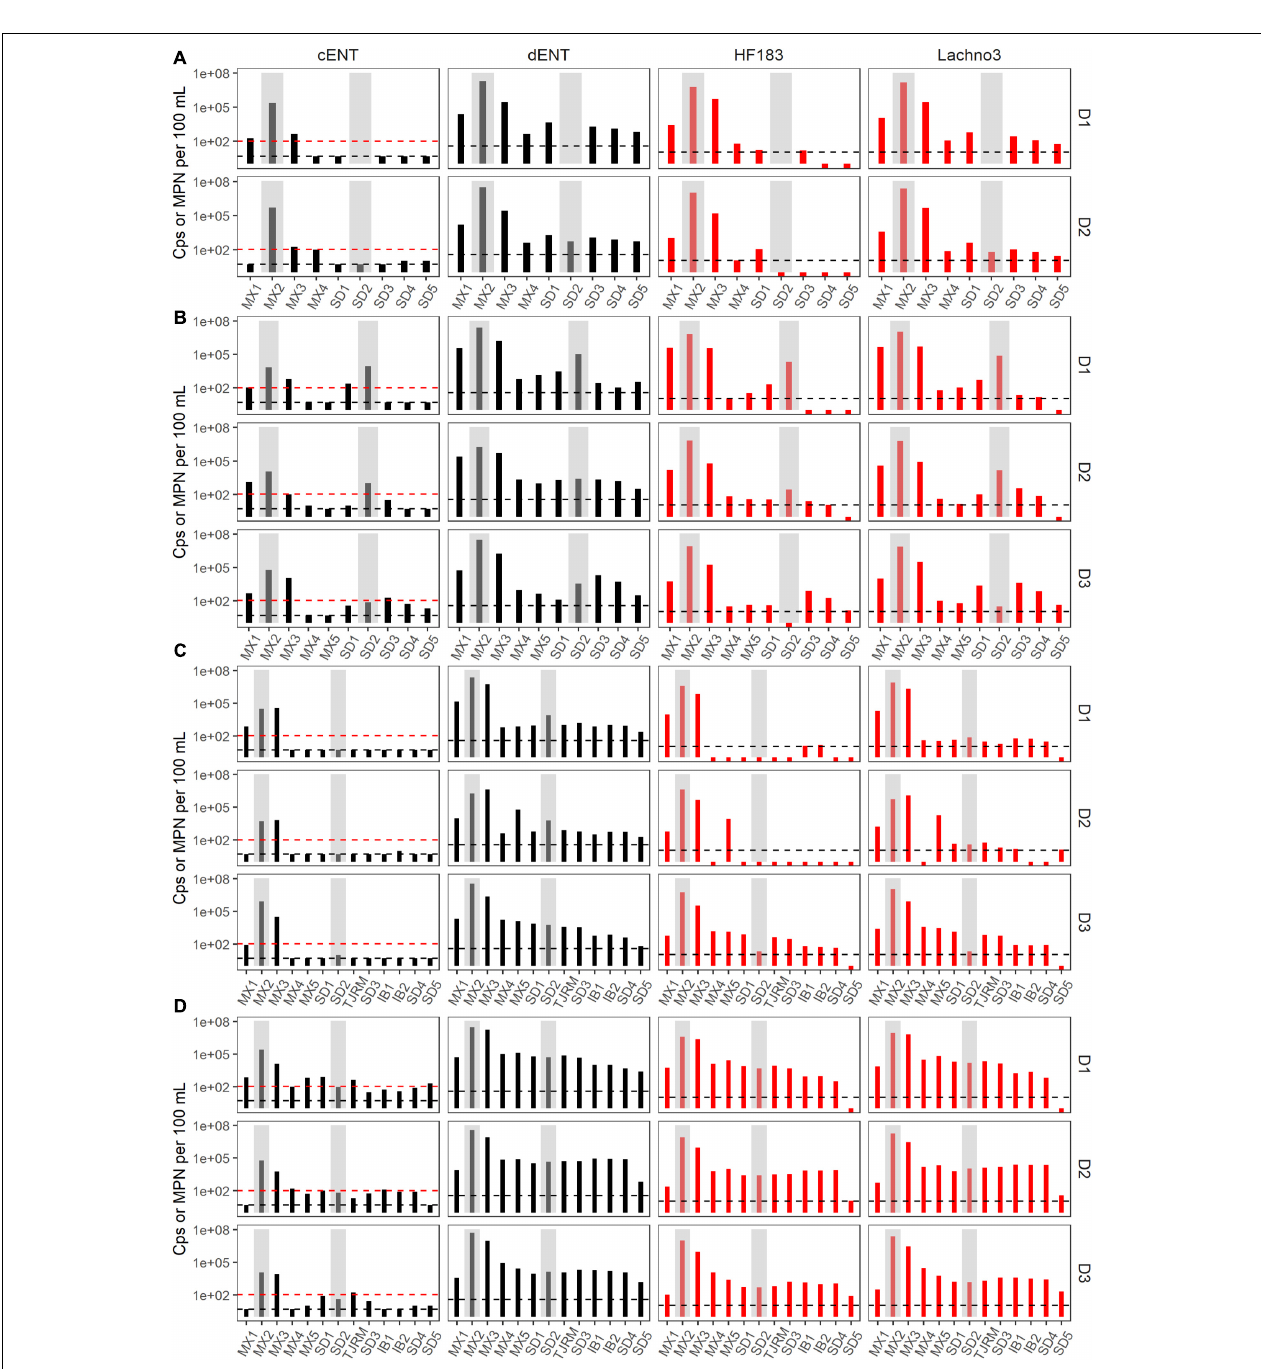
FIGURE 3 | Enterococci (black bars) by culture (cENT) and ddPCR (dENT) and human marker (red bars), HF183 and Lachno3, results for Event 1–4 (A–D) for each day sampled (D1–D3). Gray bars are overlayed on top of sites MX2 (the SADB WTP outfall at Punta Bandera) and SD2 (the Tijuana River Estuary), representing the two non-beach sites. Black dashed lines represent the limit of detection and the red dashed line indicates the single sample beach water quality public health threshold for culturable enterococci of 104 MPN per 100